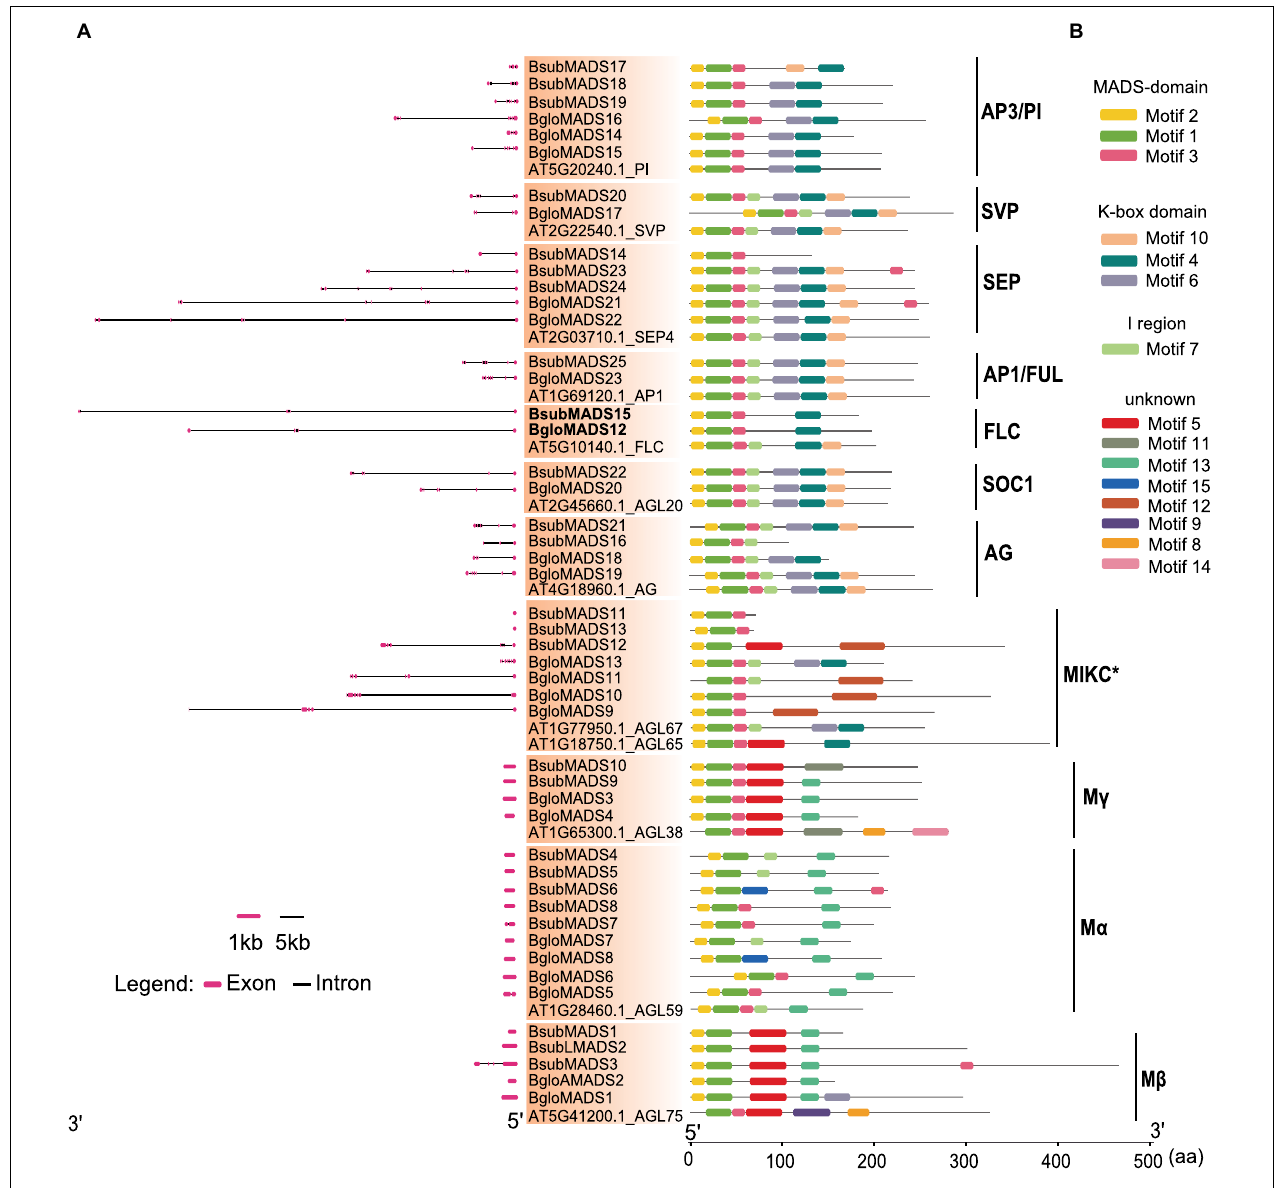
FIGURE 3 | Gene structure and conserved motifs analysis of MADS-box genes in B. subcupularis and B. fungosa var. globosa. (A) The exon-intron structure of BsubMADS genes and BgloMADS genes were predicted by Gene Structure Display Server (GSDS) (see text footnote 9). The lines represent introns, and the red boxes indicate exons. The size of the introns and exons can be calculated using the bottom scale. (B) The motifs were identified by the Multiple EM for Motif Elicitation (MEME) program (http://meme-suite.org/tools/meme). Motifs 1–15 were represented by different colors, and the gene names and different groups are shown on the left side of the figure. The ruler at the bottom indicates the amino acid length of the sequences. The details of motifs are described in Supplementary Table 7